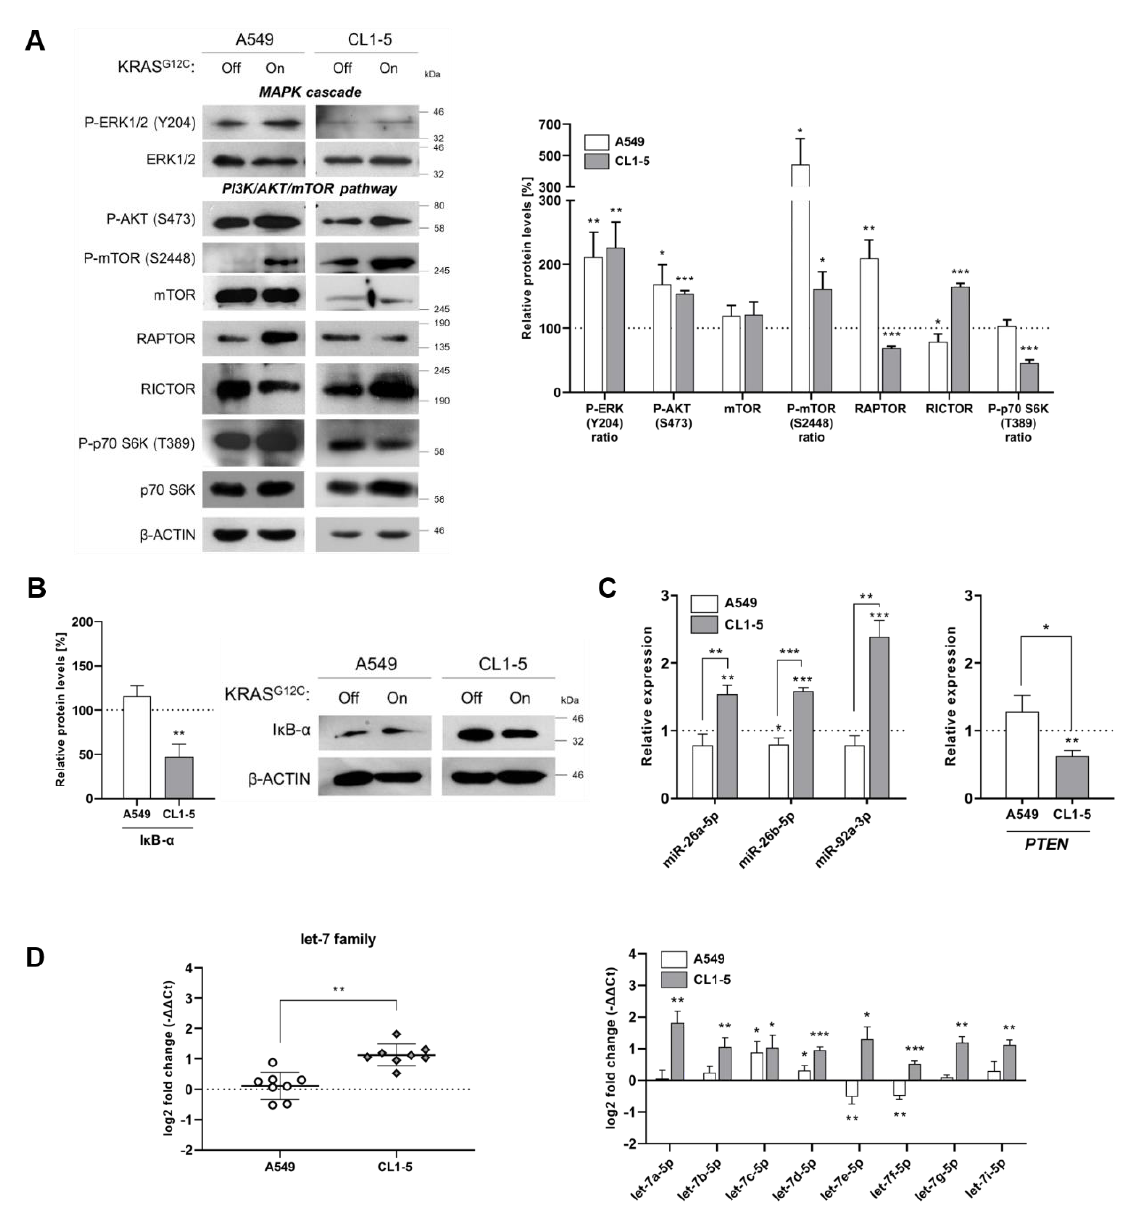
Figure 2. KRAS G12C differentially affects MAPK and PI3K/AKT/mTOR pathways effectors. ( A ) Immunoblot analysis of MAPK and PI3K/AKT/mTOR signaling effectors in A549 and CL1-5 cells before (Off) and after (On) KRAS G12C short-term induction with doxycycline. The protein levels were normalized against β -actin levels in each separate set of experiments. Band intensities are shown as a percentage (%) of relative protein levels as compared to the control (dotted line). Phosphorylation levels are shown as a ratio of phosphorylated to total relative protein levels, where indicated. ( B ) Immunoblot analysis of the IκB - α inhibitor of NF - κB in A549 and CL1 -5 cells before (Off) and after (On) KRAS G12C short-term induction with doxycycline. The protein levels were normalized against β -actin levels in each separate set of experiments. Band intensities are shown as a percentage (%) of relative protein levels as compared to the control (dotted line). ( C ) Expression levels of miRNAs and PTEN gene as measured by RT-qPCR in A549 and CL1-5 cells before (Off) and after (On) KRAS G12C short-term induction with doxycycline. All levels are shown as relative expression compared to the control (dotted line) using the 2 - ΔΔCt method. ( D ) Cumulative expression profile of all members of the let-7 family of miRNAs in A549 and CL1-5 cells before (Off) and after (On) KRAS G12C short-term induction with doxycycline (left panel). Expression levels of each member are also shown (right panel). All levels are shown as log2 fold change compared to the control (corresponding to 0 log2fold) using the - ΔΔCt method. Data are compared by using unpaired Student’s t -test and are presented as means ± SD of biological triplicates. P-values are indicated with * p < 0.05; ** p < 0.01; *** p < 0.001.